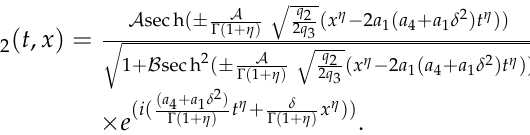
= 1, 𝑞2 = 1 = 1, 𝑎 = 0, 𝑎 = 0, 𝑞 = 1, 𝑞 = −0.1, 𝑞 = 1, 𝛾 = 1 2 4 1 2 3